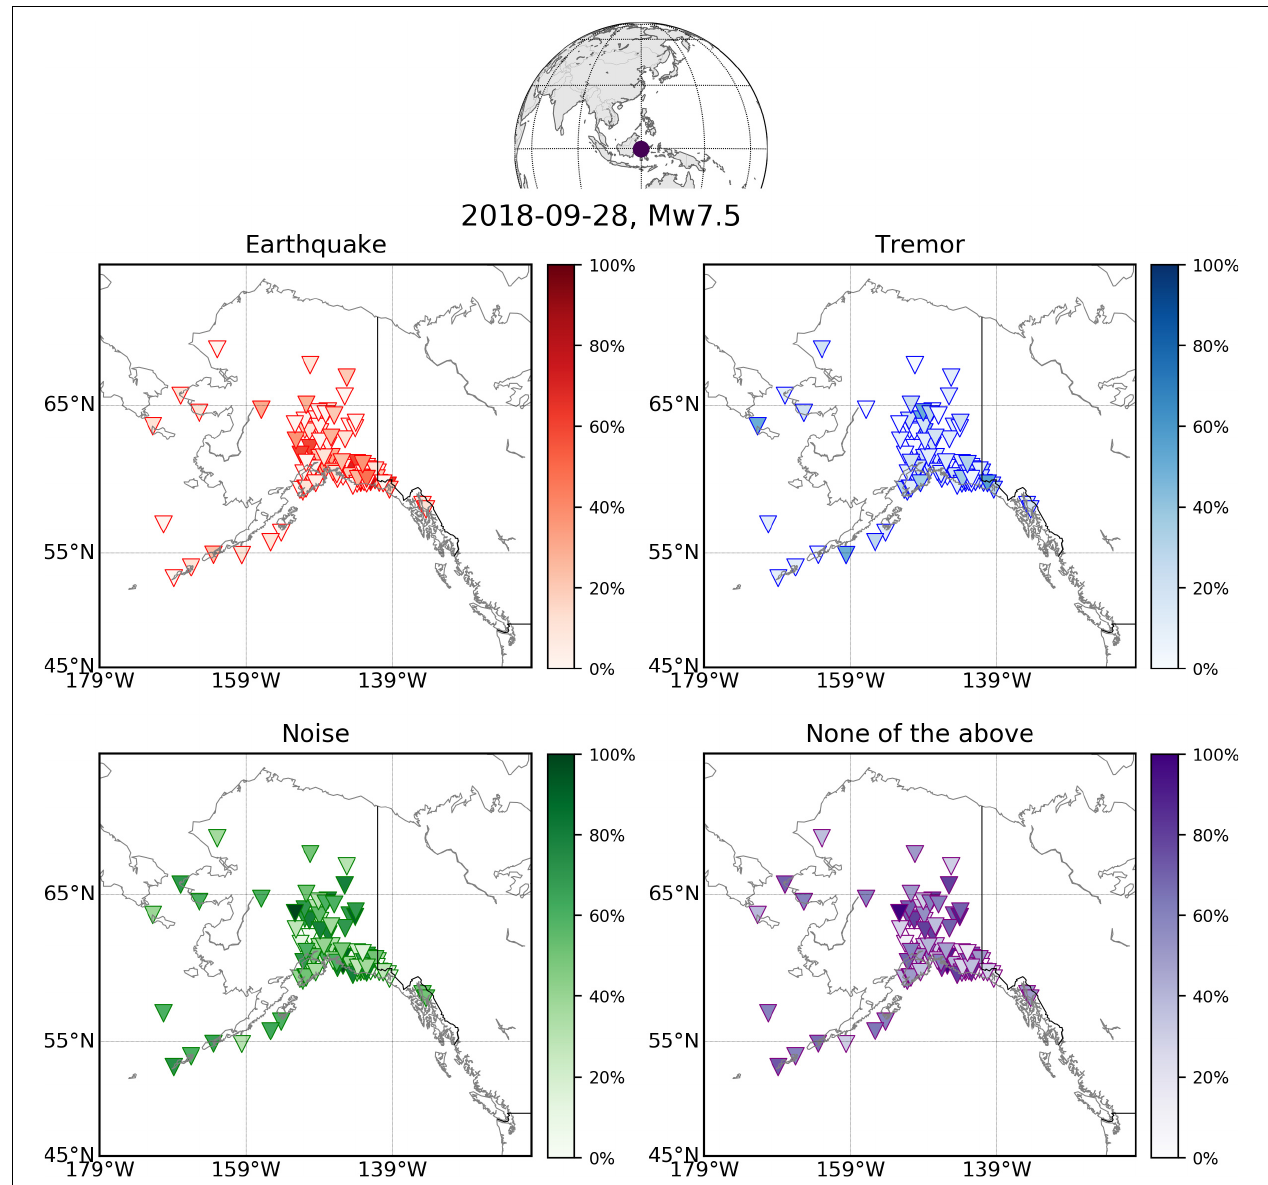
FIGURE 8 | Map of stations showing the locations of recordings where no triggered seismicity (noise) occurred for different teleseismic earthquakes.